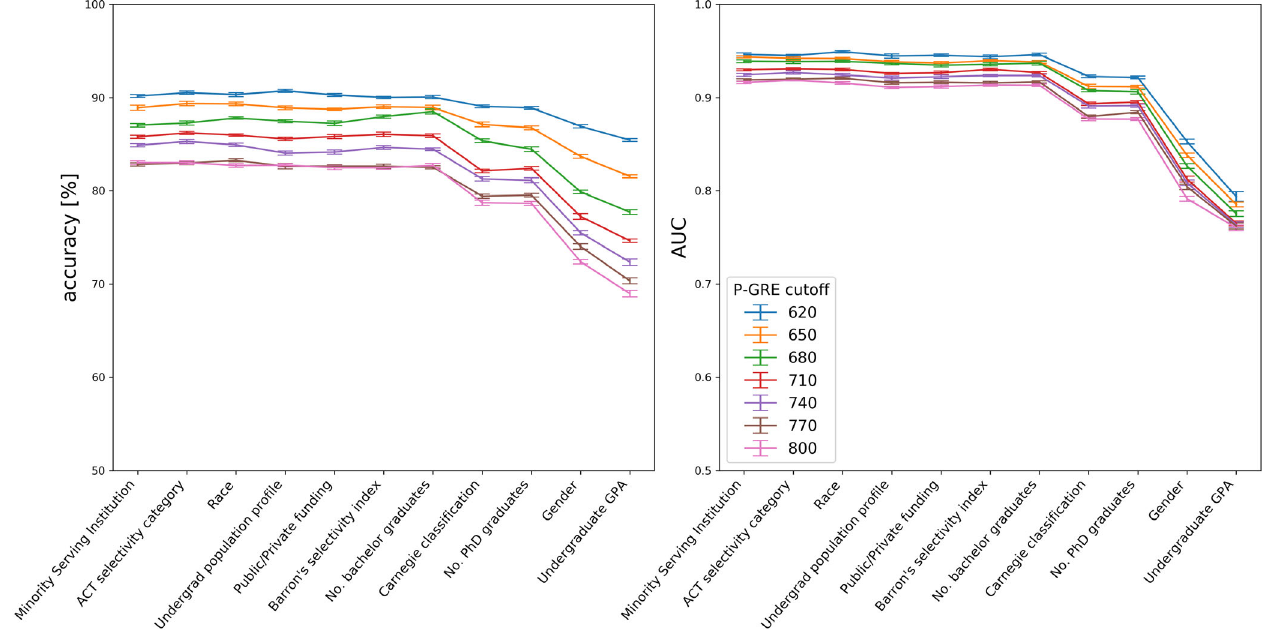
FIG. 6. Conditional inference forest feature elimination procedure. The standard errors of the K -fold ( K ¼ 10 ) estimates are indicated by the error bars. The features are eliminated from left to right, where the named feature is currently the least important feature, and thus the next to be dropped from the model.